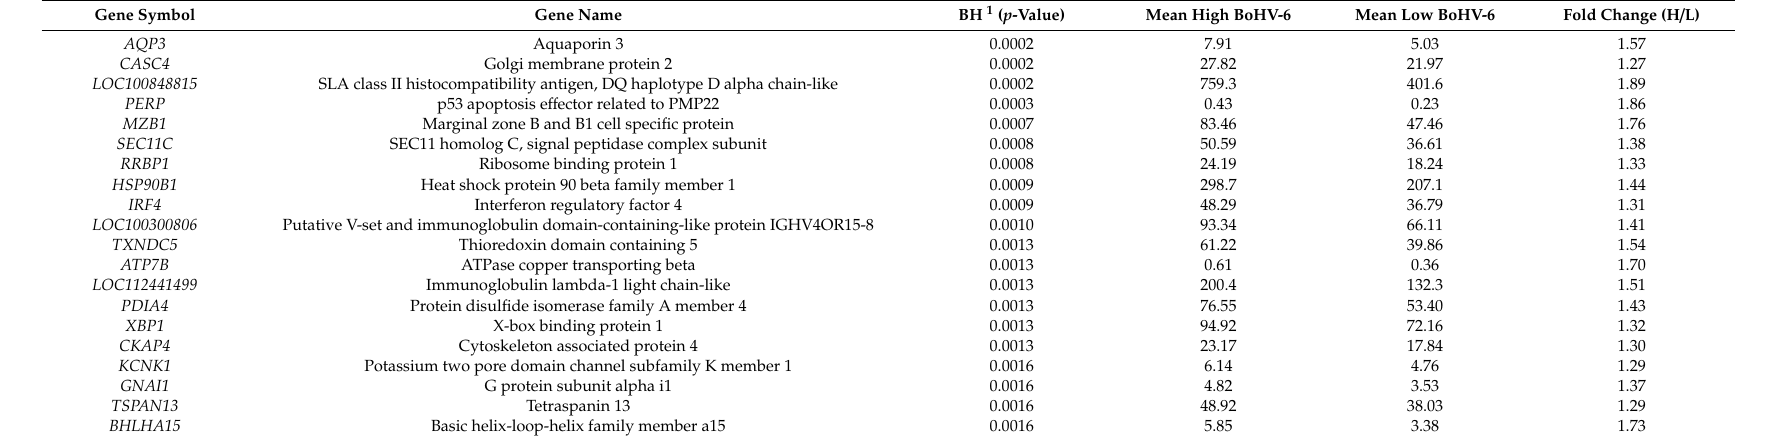
Table 5. Gene expression levels in circulating leukocytes collected at around 14 days in milk compared between cows with High (H, > 200) and Low (L, 1-200) BoHV-6 scores, listing the 20 most significant DEG (all up-regulated in High score